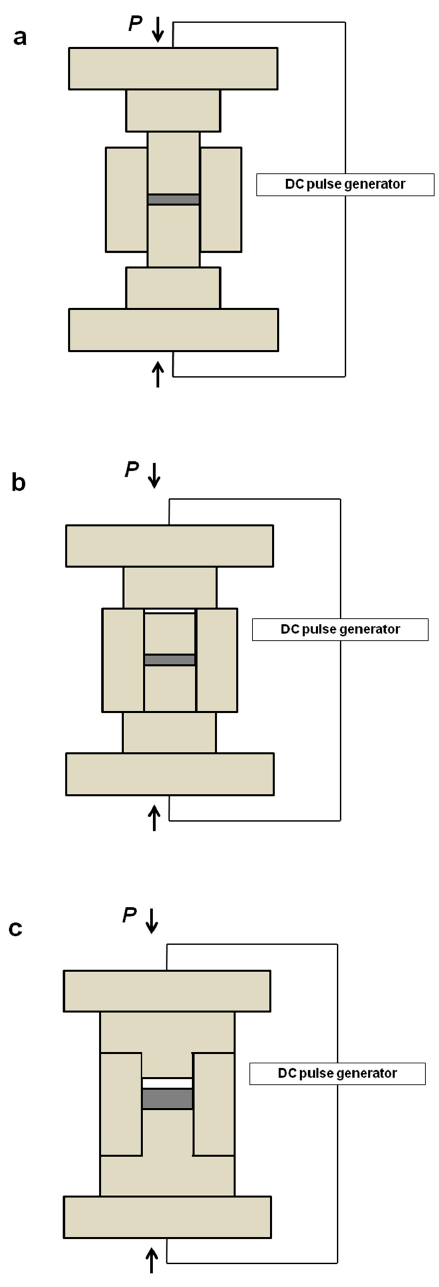
Figure 2. Tooling for pressure-assisted ( a ) and pressureless SPS (( b ) [20 – 22], ( c ) [23 – 24]).